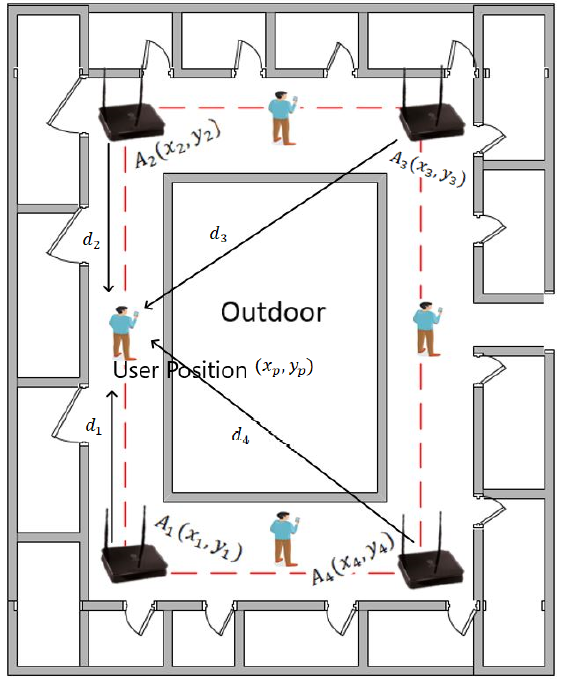
Figure 2. Wi-Fi localization system using